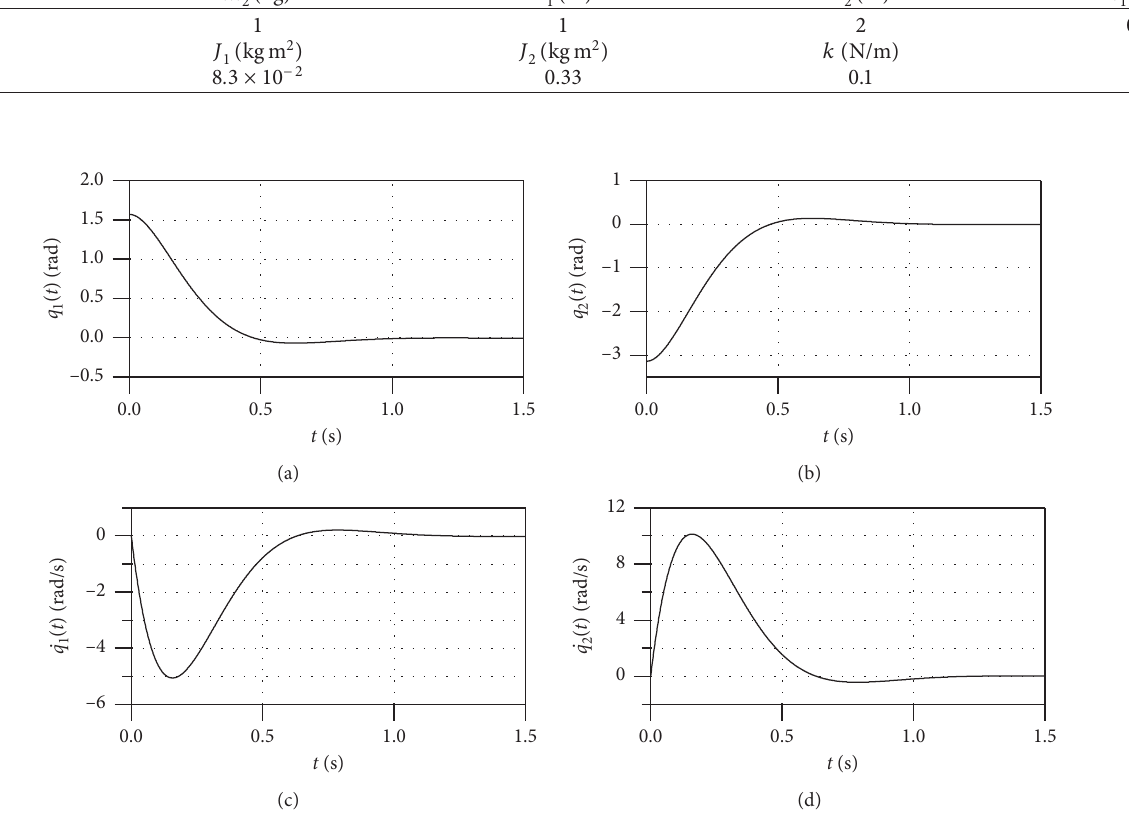
( t ) and _ q ( t ) ( i � 1 , 2 ) with initial condition i i